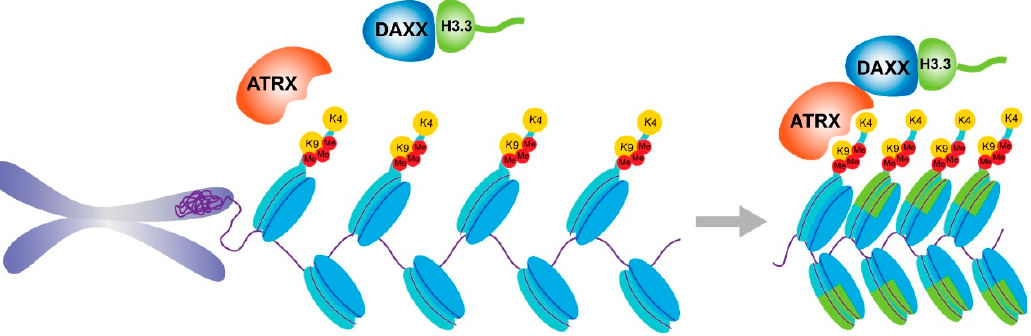
Figure 2. ATRX recognized H3K9me3 and worked with DAXX to deposit H3.3 at telomeres and preserve heterochromatin.